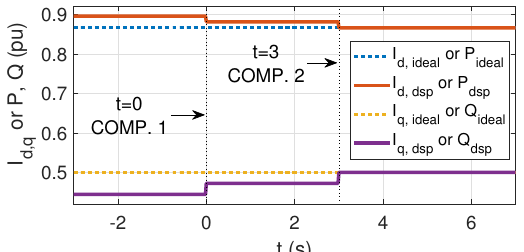
Figure 7. Comparison of the currents during the control stage with the ideal “reference current” and the generated one from